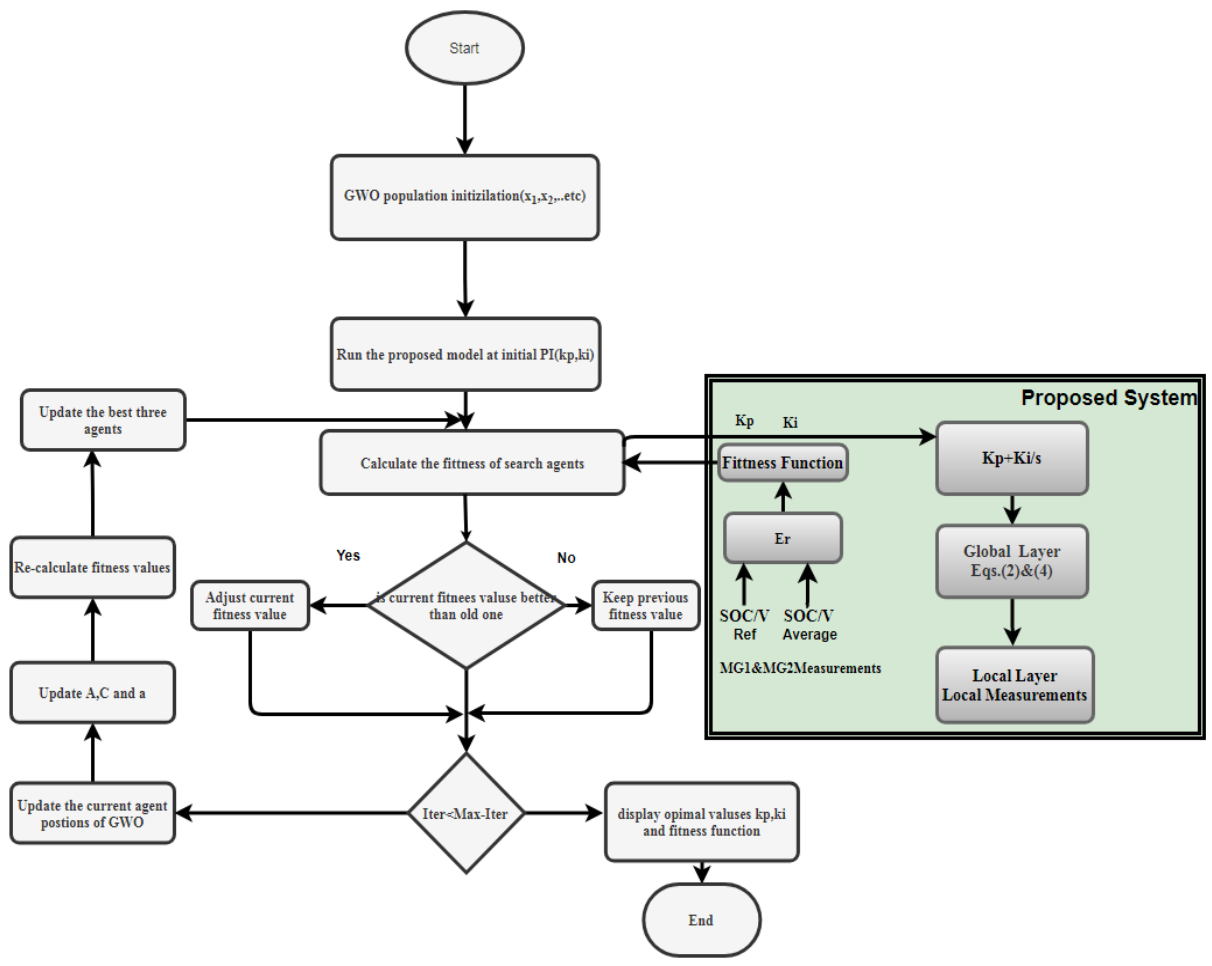
Figure 8. The GWO algorithm for the global control layer.